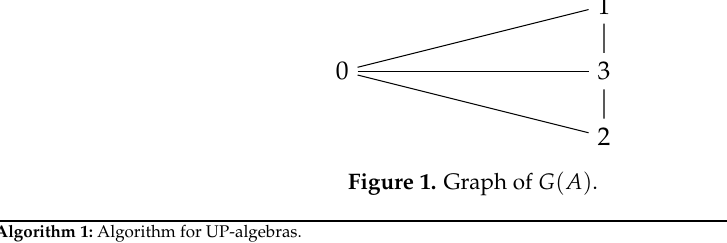
Algorithm 1: Algorithm for UP-algebras. : binary Input ( A : set, ∗